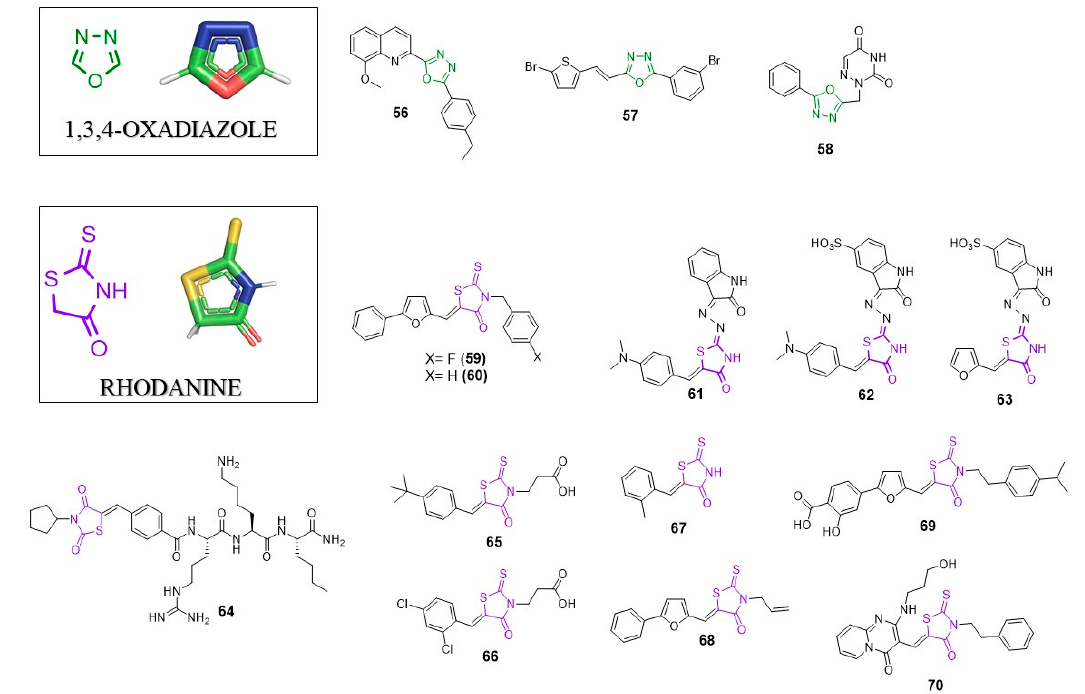
Figure 6. 1,3,4-Oxadiazole and rhodanine containing antivirals.